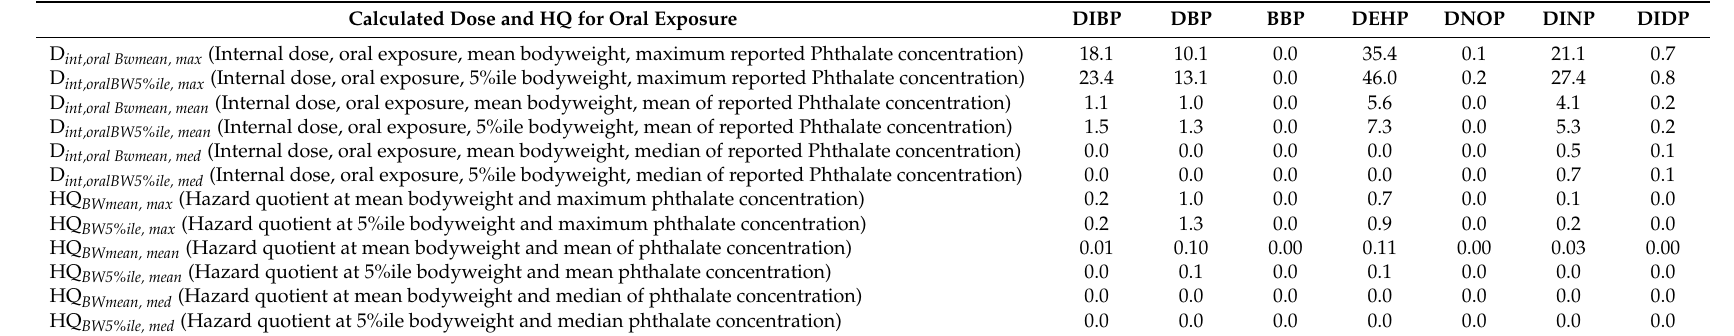
Table 4. Calculated dose ( µ g/kg bw/day) and HQ for oral exposure to phthalates at maximum, mean and median exposure concentrations. Calculated Dose and HQ for Oral